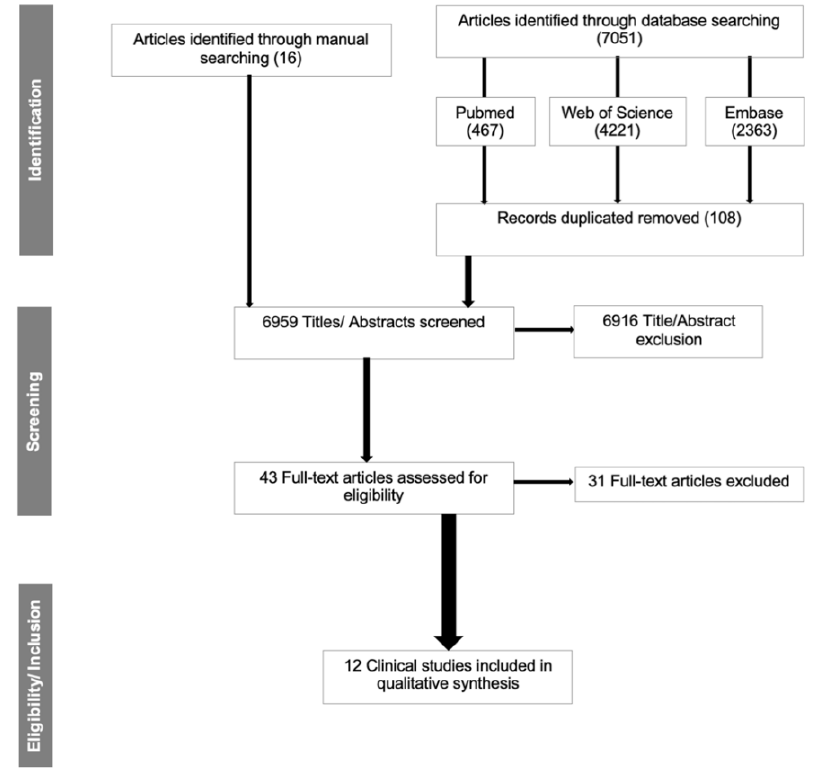
Table 3. Twelve articles [33–44] met the inclusion criteria and were included in the current review (Figure 1).